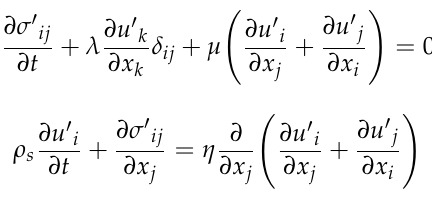
− U are the peak is the Reynolds number in terms of U − U jet EROA RF U D jet (cm) (mm 2 ) (%) (m/s)